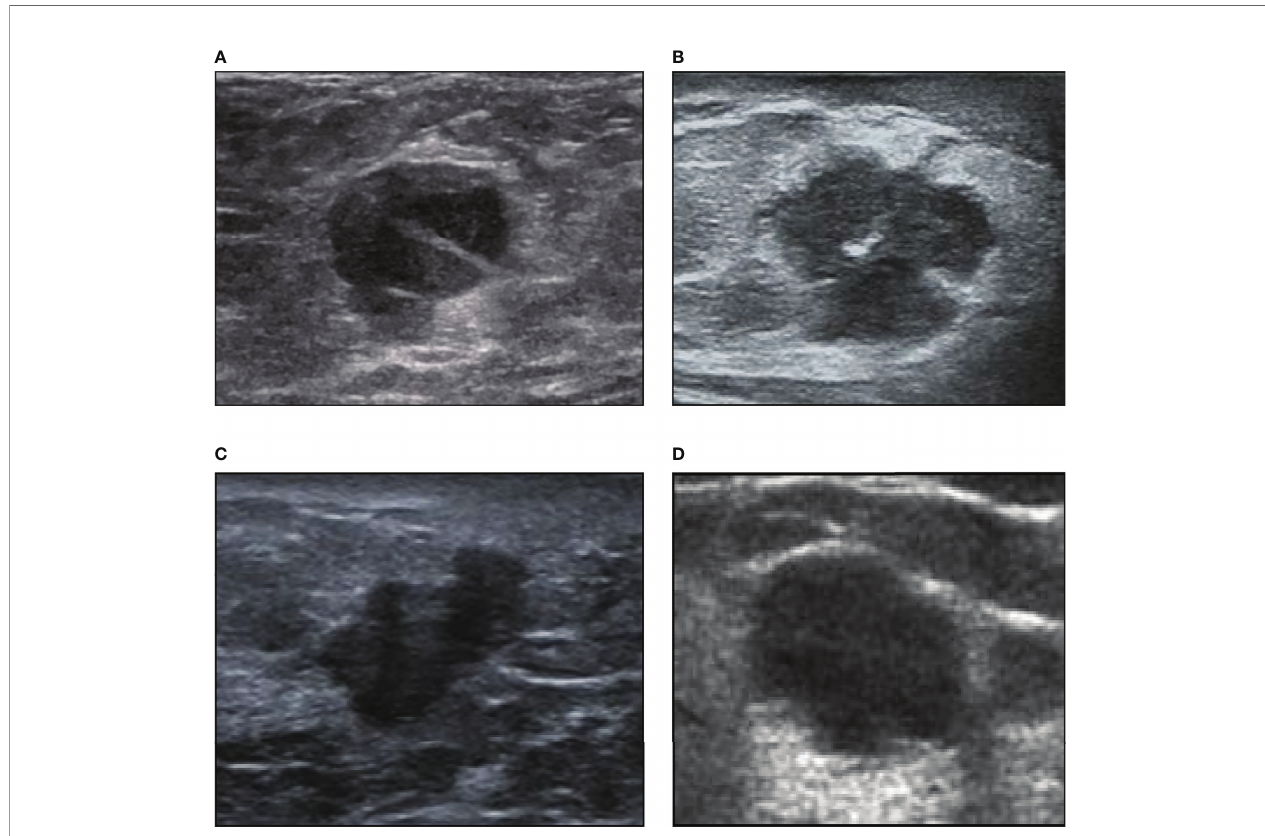
FIGURE 1 | Examples of our ultrasound image dataset. (A) A 72-year-old woman with intraductal papillary breast carcinoma (1.6cm) of luminal A subtype. (B) A 56-year-old woman with invasive ductal breast carcinoma (1.7cm) of luminal B subtype. (C) A 40-year-old woman with invasive micropapillary breast carcinoma (1.5cm) of HER2+ subtype. (D) A 39-year-old woman with invasive ductal breast carcinoma (1.9cm) of triple-negative